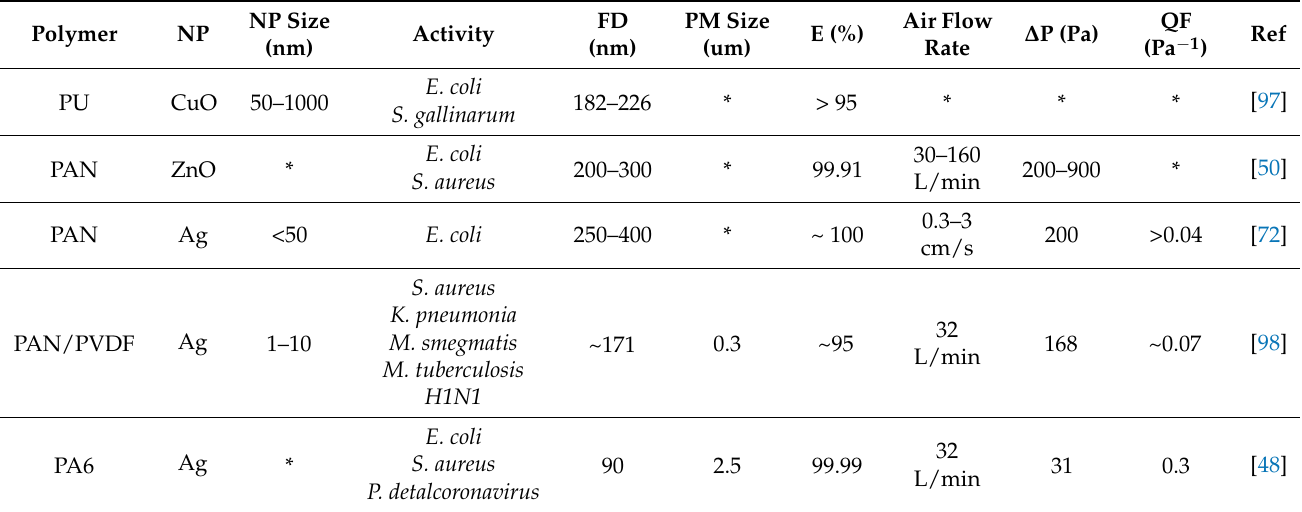
Table 2. Electrospun nanofibers containing inorganic nanoparticles used for the development of air filters reported in literature. FD—fiber’s diameter; NP—nanoparticle type; NP